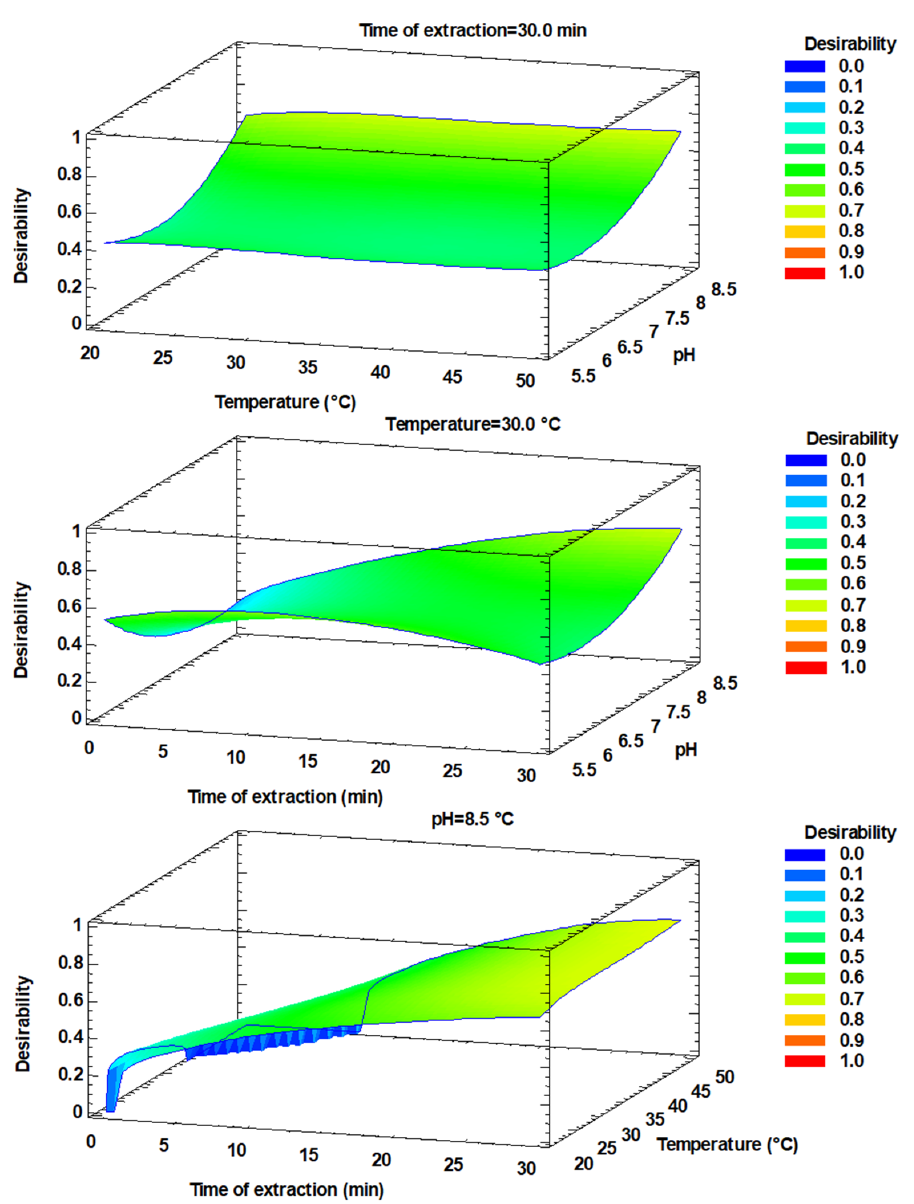
Figure 8. Influence of the different extraction conditions on the optimization desirability for the higher yield of all the studied responses. The fixed factor in each graph has been set at its optimal value.